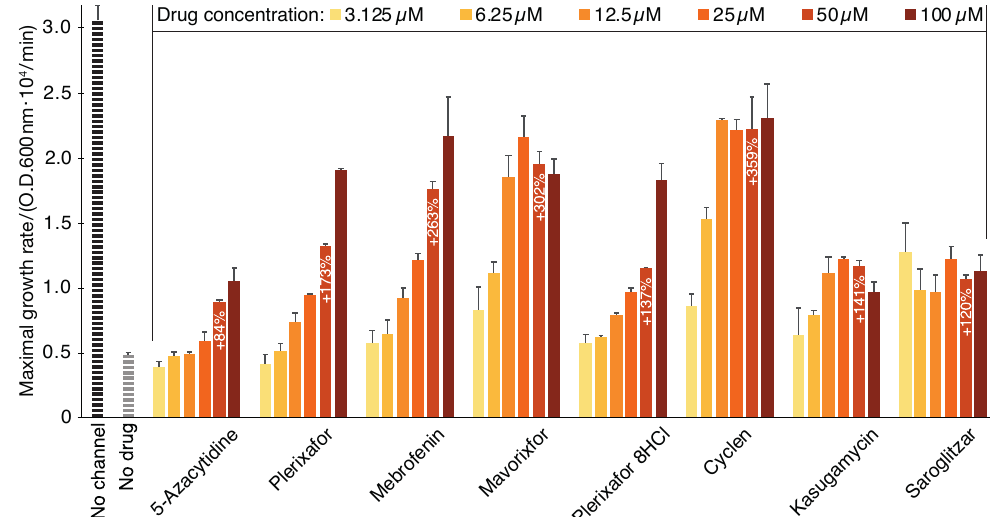
Figure 1. Compound screening results using the negative assay. SARS-CoV-2 E protein is expressed at an elevated level (induction with 100 µM [ β - D -1-thiogalactopyranoside]) and is therefore deleterious to bacteria. In this instance, inhibitory drugs enhance bacterial growth. The results may be compared to those obtained without any drug (gray) or when the channel is uninduced (black). The color scale Version June 10, 2021 submitted to Pharmaceuticals 3 of 19 indicates the different concentrations of the chemicals.